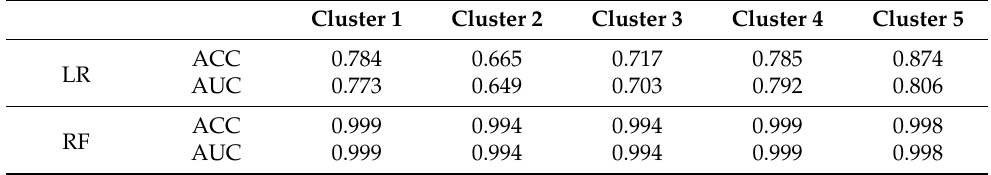
Table 8. The fitting results of logistic regression and random forest using the training